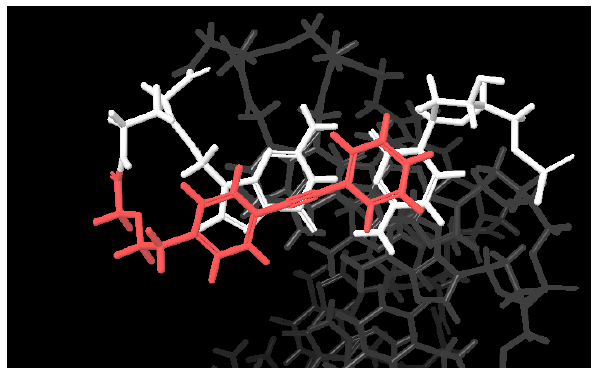
Figure 5. Conformational search of tolane6-PNA/DNA using MacroModel. Force Field; OPLS2005, Solvent: water, Red; tolane. White; terminal base pairs.